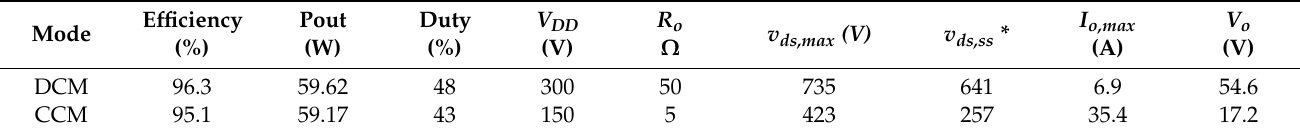
Table 6. Comparison of DCM and CCM at 60 W output when turn ratio a = 6.24.